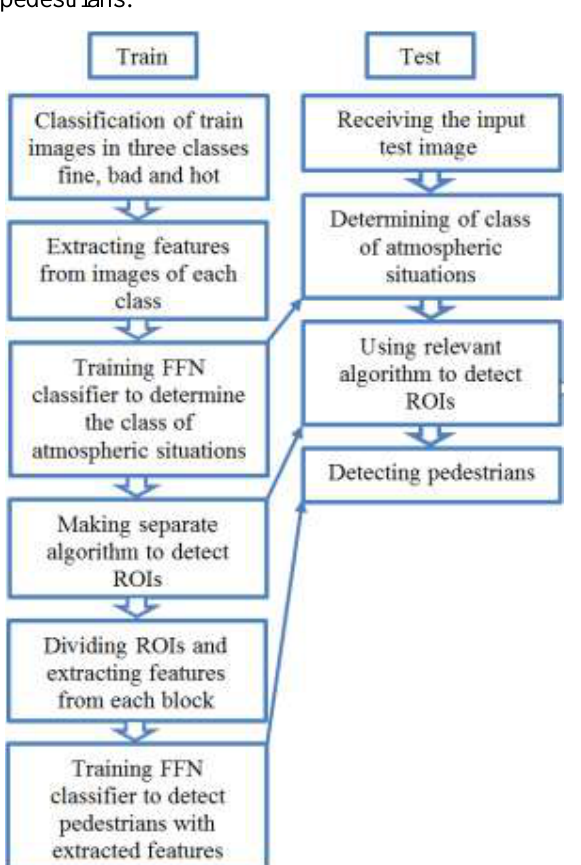
Figure 4. Block diagram of proposed method.